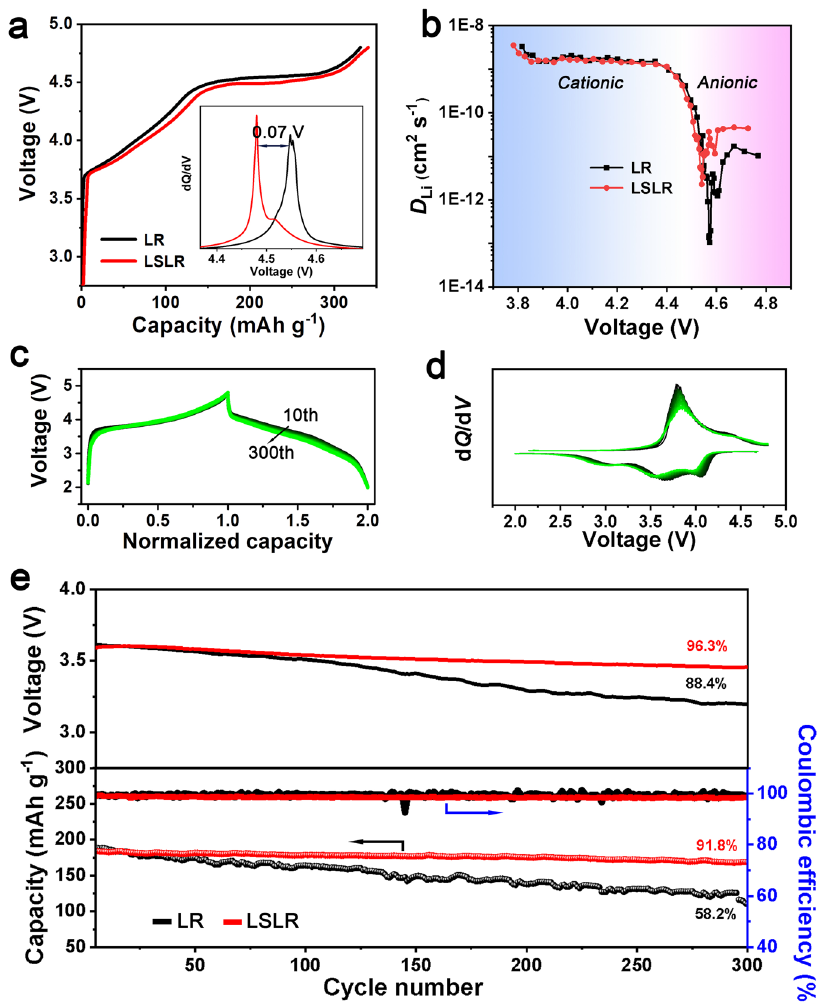
Fig. 2 Electrochemical characterizations of LR and LSLR. a The initial charging plots for LR and LSLR. The inset displays the corresponding d Q /d V curves. b , The calculated Li + diffusion coef fi cient from GITT. c , d Normalized voltage-capacity pro fi les for the 10th cycle ( c ) and d Q /d V curves for the 10th cycle ( d ) for LSLR, n is from 1 to 30. e Cycling performance at 1 C rate for LR and LSLR, 1 C is set as 250 mA g − 1 . Source data are provided as a Source Data fi